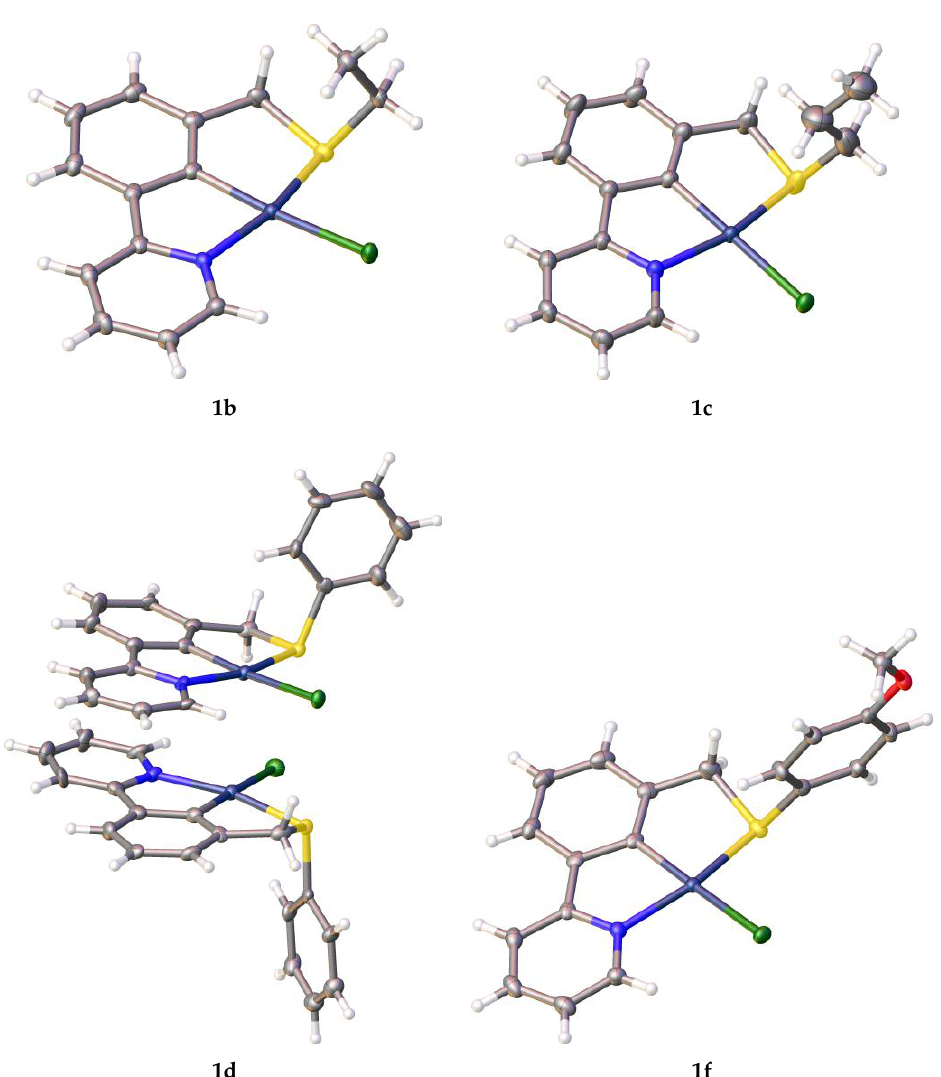
Figure 2. X-ray crystallographic structures of 1b – d , 1f .